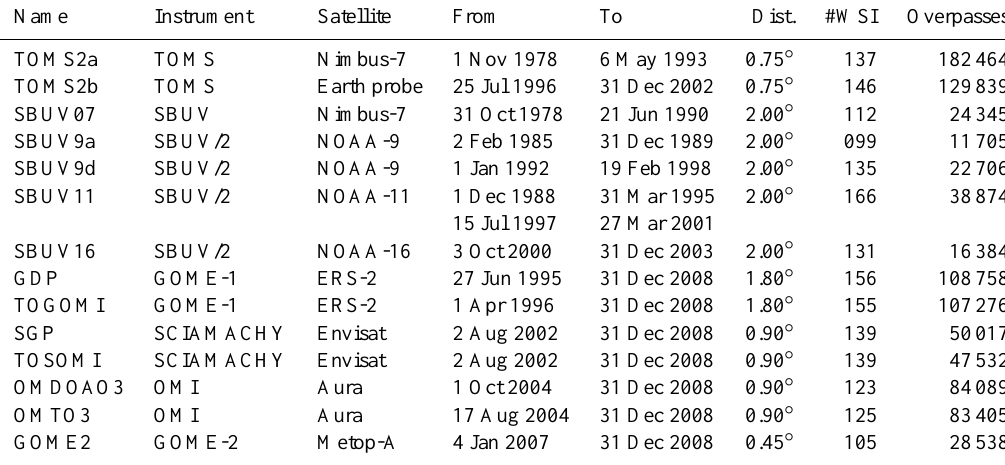
Table 1. The satellite datasets used in this study. The columns show the name of the dataset, the satellite instrument on which it is based, the satellite, the period(s) used, the maximum distance allowed in an overpass, the number of ground instruments (WSI) and the total number of overpasses for this